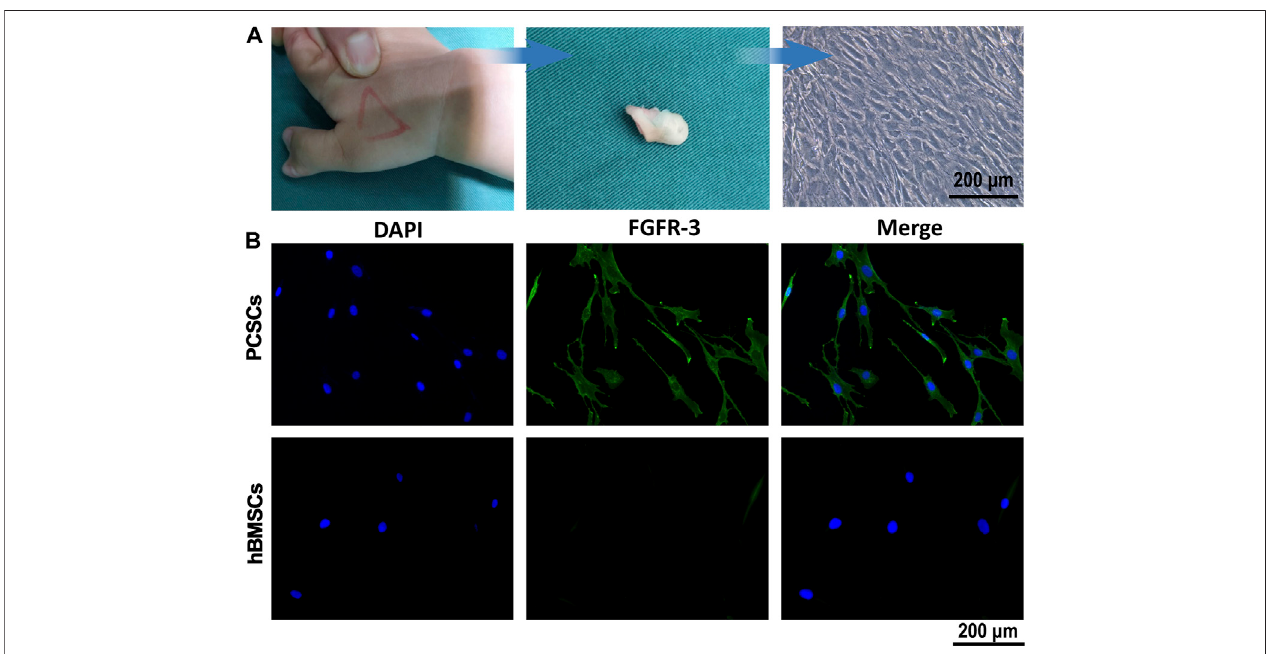
FIGURE 1 | Isolation and identi fi cation of PCSCs. (A) Process of isolation of PCSCs from the ring of La-Croix extracted from polydactylism patient. (B) Representative images of immunostaining for DAPI (blue) and FGFR-3 (green), and hBMSCs were used as control.